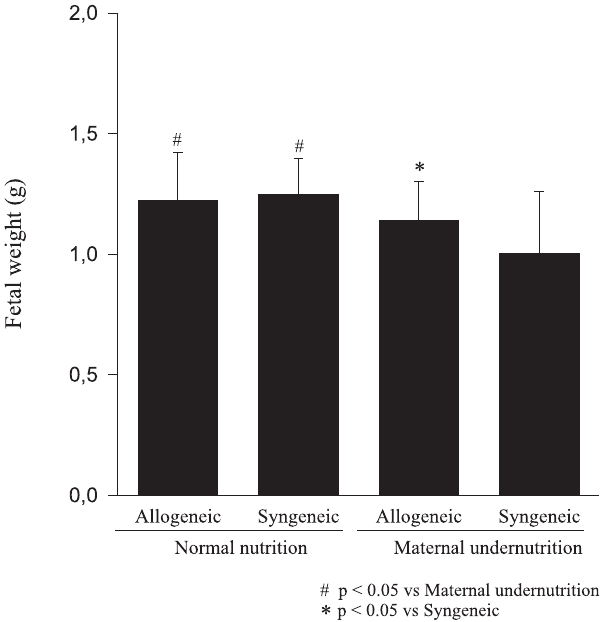
Figure 1 - Effect of type of maternal diet and maternal-fetal genetic compatibility on fetal weight (mean ±